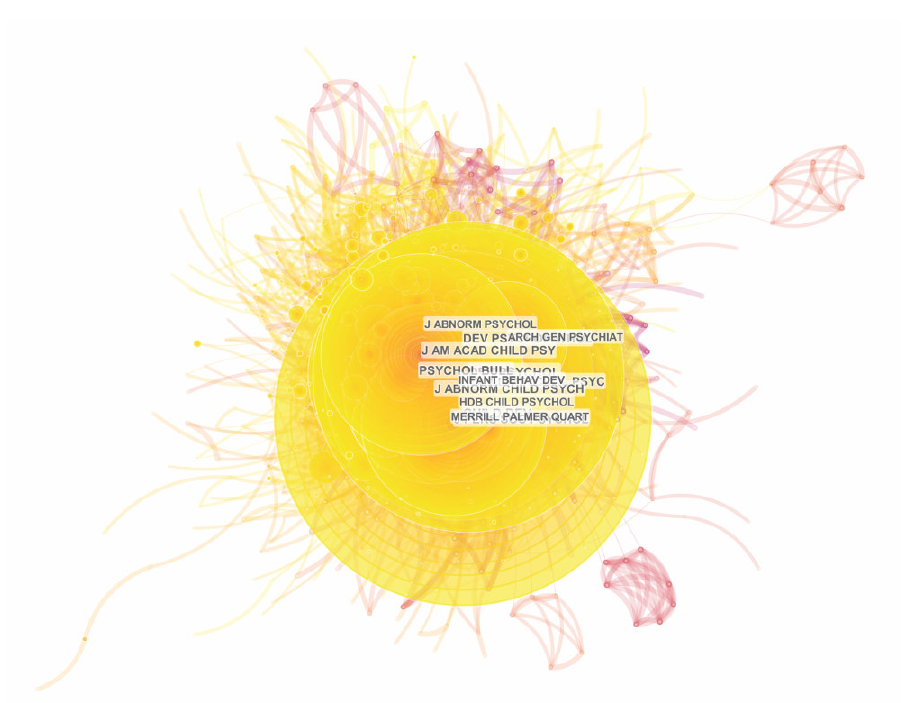
Figure 5. The Network Structure of Citations by